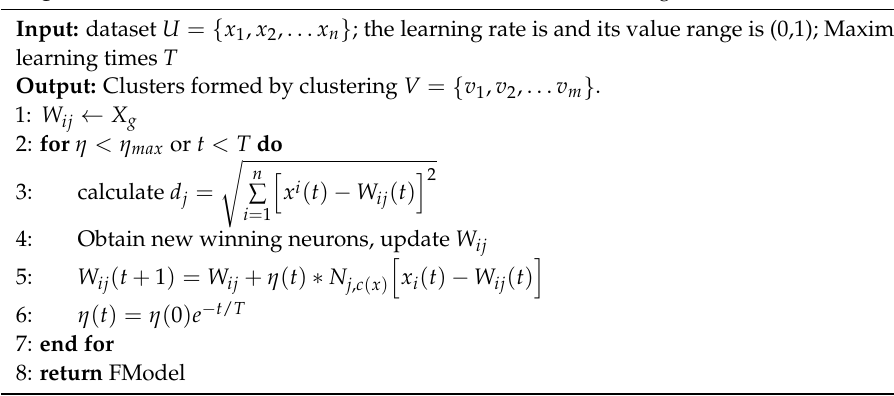
Algorithm 3 SFLA—Kohonen networks to achieve data